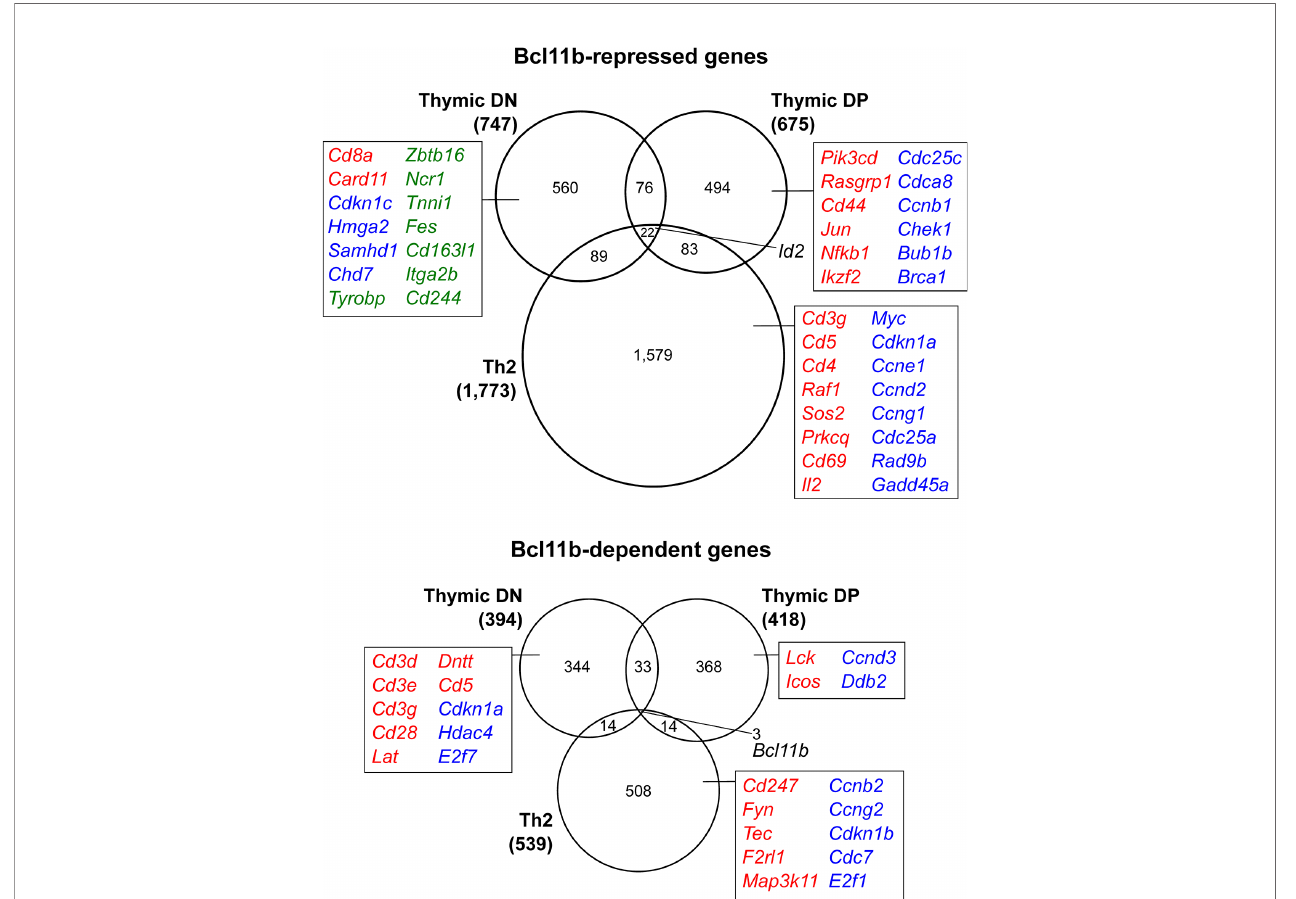
FIGURE 3 | Context-dependent transcriptional regulation by Bcl11b. Genes differentially expressed in the absence of Bcl11b in thymic double negative cells (40), double positive cells (14) and Th2-polarized mature CD4 T cells (41). Selected genes involved in T cell receptor signaling (red), regulation of cell cycle (blue) or alternative lineage differentiation (green) are highlighted to exemplify processes that display varying Bcl11b-dependent regulation in developmentally distinct cellular contexts. Gene lists extracted from Table S3 of reference (40) ( ‘ high con fi dence ’ targets identi fi ed as differentially expressed in at least two of the three Bcl11b deletion models), Table S1 of reference (14) and Table S1 of reference